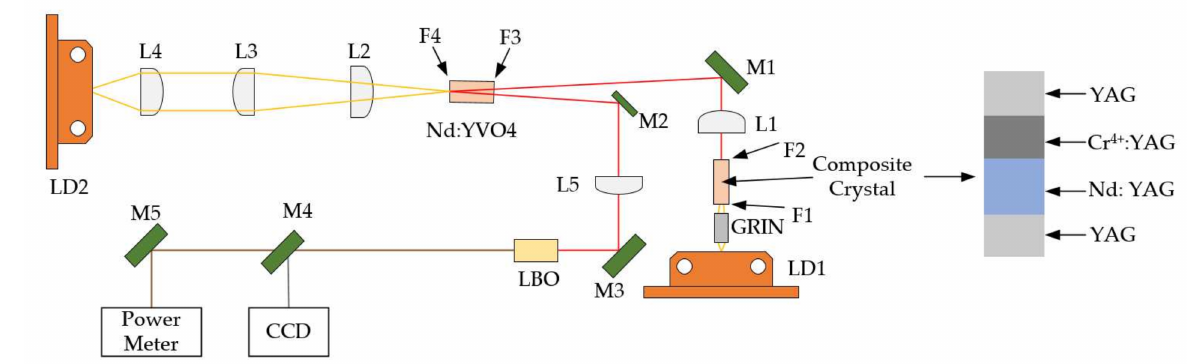
Figure 1. Schematic of the sub-nanosecond